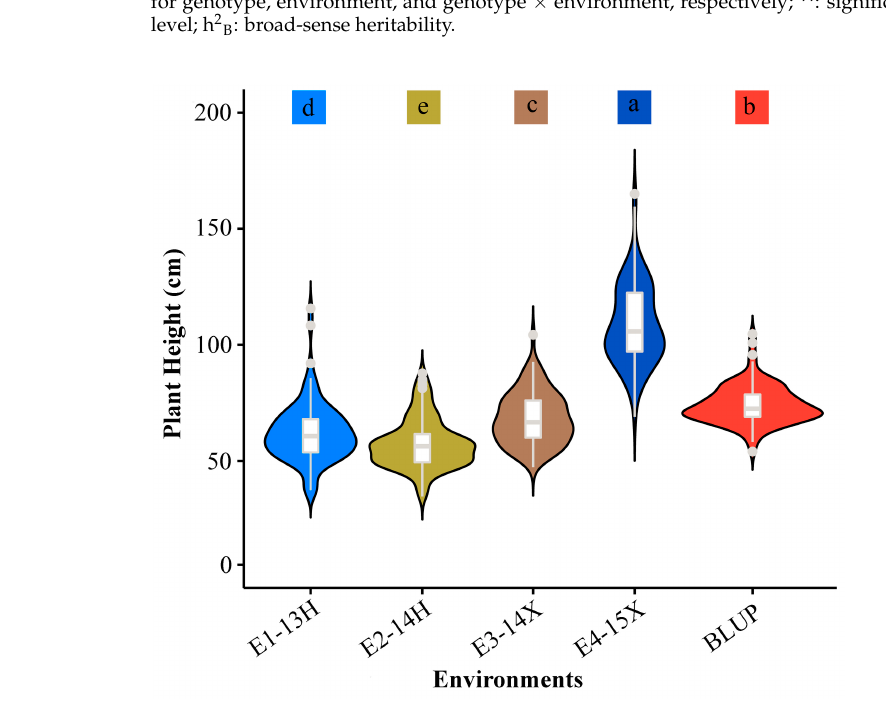
Figure 1. Phenotypic variation in the plant height of tobacco in different environments. The gray color in the box indicates the median; the white boxplot in violin shows the range from the lower quartile to upper quartile; the black line indicates the frequency distribution and dispersion of the phenotypic data. Different letters indicate significant differences between environments and BLUP values using the LSD test at p < 0.05. Table 1. Descriptive statistics for plant height in 94 tobacco accessions in four environments.